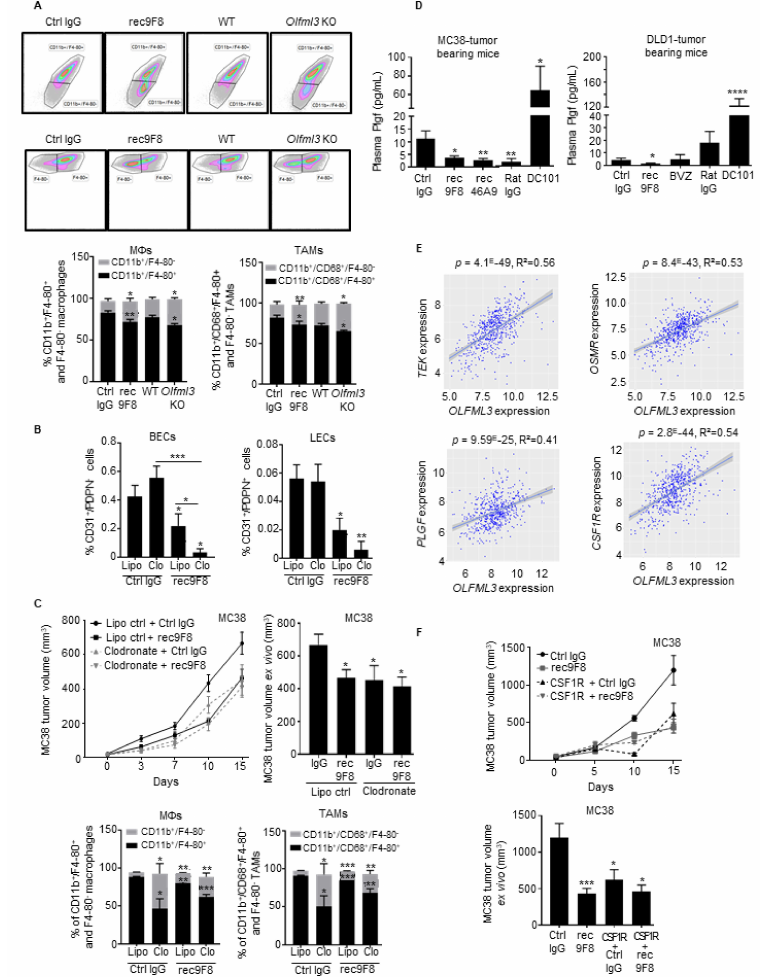
Figure 5. Anti-OLFML3 antibodies or deletion of Olfml3 from mice reduces the percentage of tumor-associated macrophages (TAMs) in MC38 tumors. ( A ) Upper panel: flow cytometry gating strategy for immature and mature macrophages (upper plot) and TAMs (lower plot) in single-cell suspensions of MC38 tumors in wild-type (WT) mice treated with control or rec9F8 antibodies, or in Olfml3 WT or KO mice. Lower panel: quantification of immature (CD11b + /F4-80 − ) and mature (CD11b + /F4-80 + ) macrophages ( left ) and immature (CD11b + /CD68 + /F4-80 − ) and mature (CD11b + /CD68 + /F4-80 + ) TAMs ( right ). Columns represent the percentage of cells, and error bars represent the mean ± SEM; * p < 0.01; ** p < 0.01. ( B ) Quantification of blood vascular (BECs; CD31 + /PDPN − ) and lymphatic (LECs; CD31 + /PDPN + ) endothelial cells in MC38 tumors isolated from mice treated with clodronate-loaded liposomes, rec9F8 mAbs, and their respective controls. Columns represent the mean ± SEM; bars ( right ), * p < 0.05; ** p < 0.01; *** p < 0.001. ( C ) Growth curves ( left ) and size of ex vivo MC38 tumors at the end of the experiment ( right ) from mice treated with rec9F8 mAb alone or in combination with clodronate-loaded liposomes, control liposomes, or control mAbs ( n = 8–11 per group). Lower panels: Quantification of immature (CD11b + /F4-80 − ) and mature (CD11b + /F4-80 + ) macrophages ( left ) and immature (CD11b + /CD68 + /F4-80 − ) and mature (CD11b + /CD68 + /F4-80 + ) TAMs ( right ) in MC38 tumors isolated from mice treated with clodronate-loaded liposomes, rec9F8, and their respective controls. Bars ( right ) represent the mean ± SEM; * p < 0.05; ** p < 0.01; *** p < 0.001. ( D ) Quantification of Plgf plasma levels in mice bearing DLD1 tumors treated with rec9F8, bevacizumab, DC101, or the corresponding IgG control mAbs (Ctrl IgG, Rat IgG) ( right ), and in mice harboring MC38 tumors treated with rec9F8, rec46A9, DC101, or the corresponding control IgG antibodies ( left ). Bars represent the mean ± SEM of three experiments; * p < 0.05; ** p < 0.01; **** p < 0.0001. ( E ) Scatter plot comparing mRNA levels of TEK, OSMR, PLGF, and CSF1R with those of OLFML3 in tumor samples from CRC patients. Differences were evaluated using Pearson’s correlation and Spearman’s rank correlation analysis. ( F ) Tumor growth curves (upper panel) and ex vivo tumor volume (lower panel) of end-stage MC38 tumors isolated from mice treated with rec9F8 mAb alone or with rec9F8 mAb plus an anti-CSF1-R blocking mAb ( n = 8–10 per group). Bars represent the mean ± SEM; * p < 0.05; *** p <